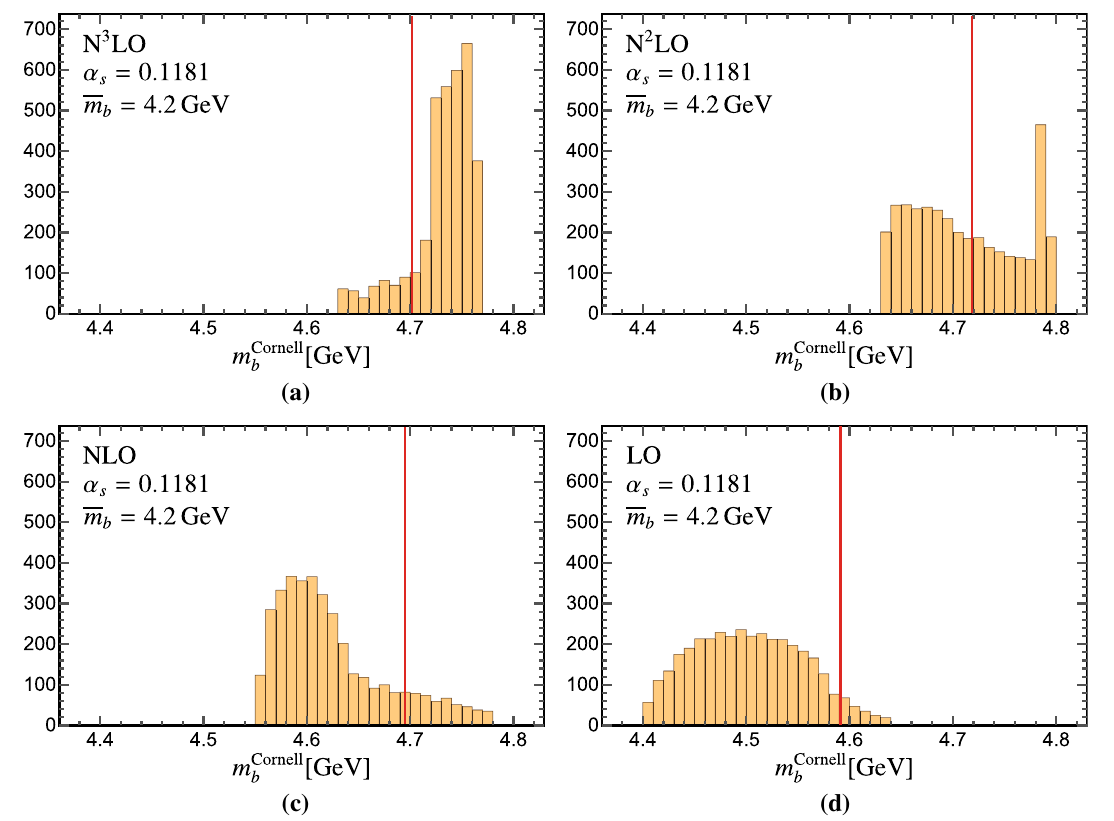
Fig. 10 Distribution of Cornell masses in the theory renormalization scale scan for m b = 4 . 2GeV using the world average value for the strong coupling constant when compared to QCD results at N 3 LO ( a ),